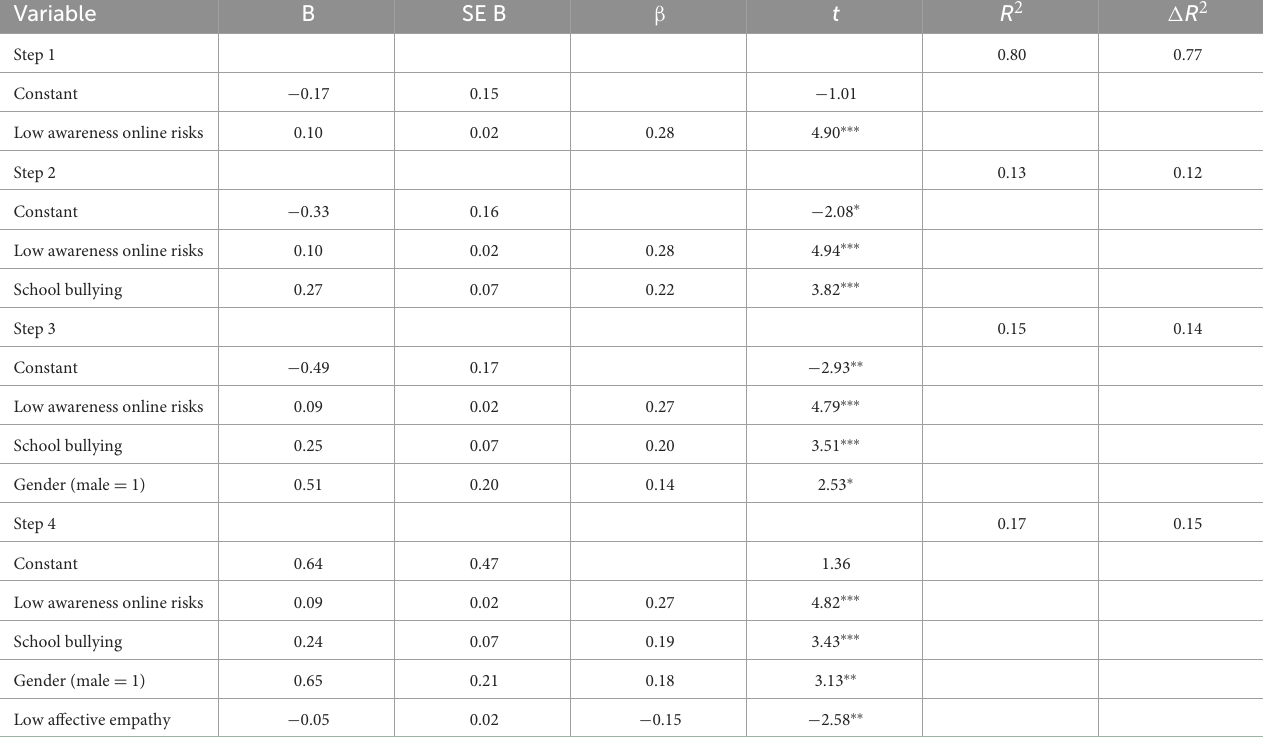
TABLE 3 Multiple linear regression analysis (stepwise) results regarding onset of